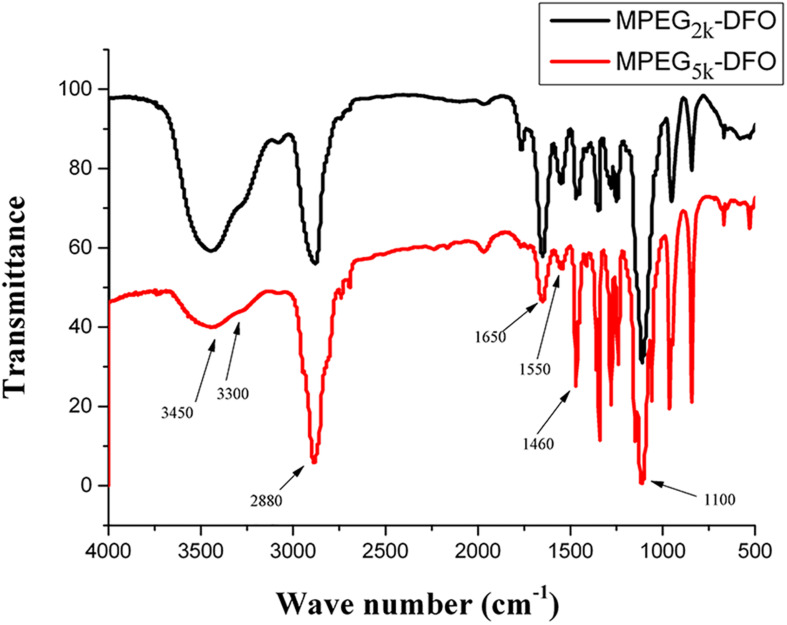
FTIR spectra of PEGylated DFO.